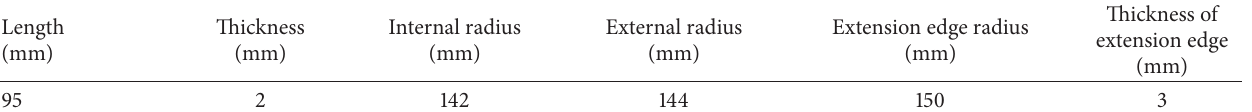
Figure 1: TCS and its clamped circular ring used in bolt looseness boundary. Table 1: Dimension parameters of thin cylindrical shell.